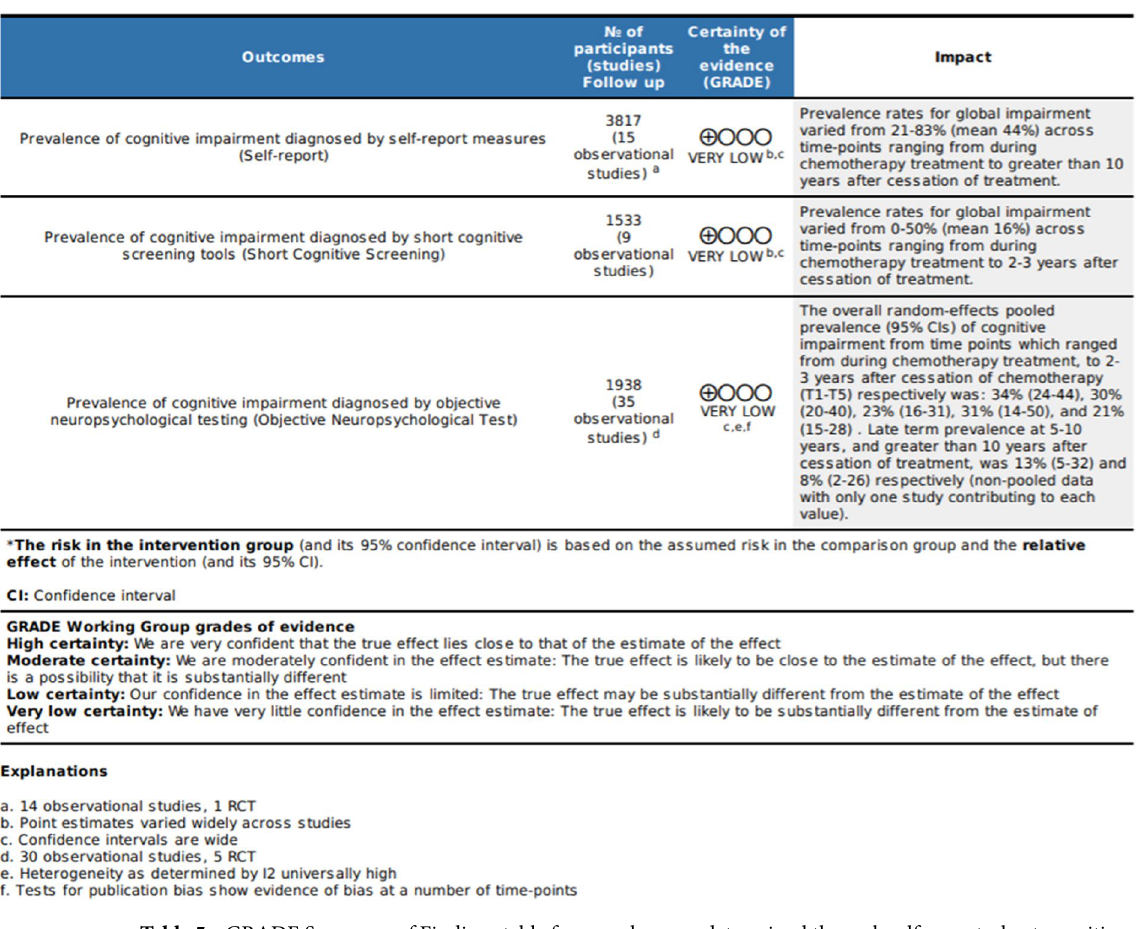
Table 5. GRADE Summary of Findings table for prevalence as determined through self-report, short cognitive screening tests and neuropsychological test